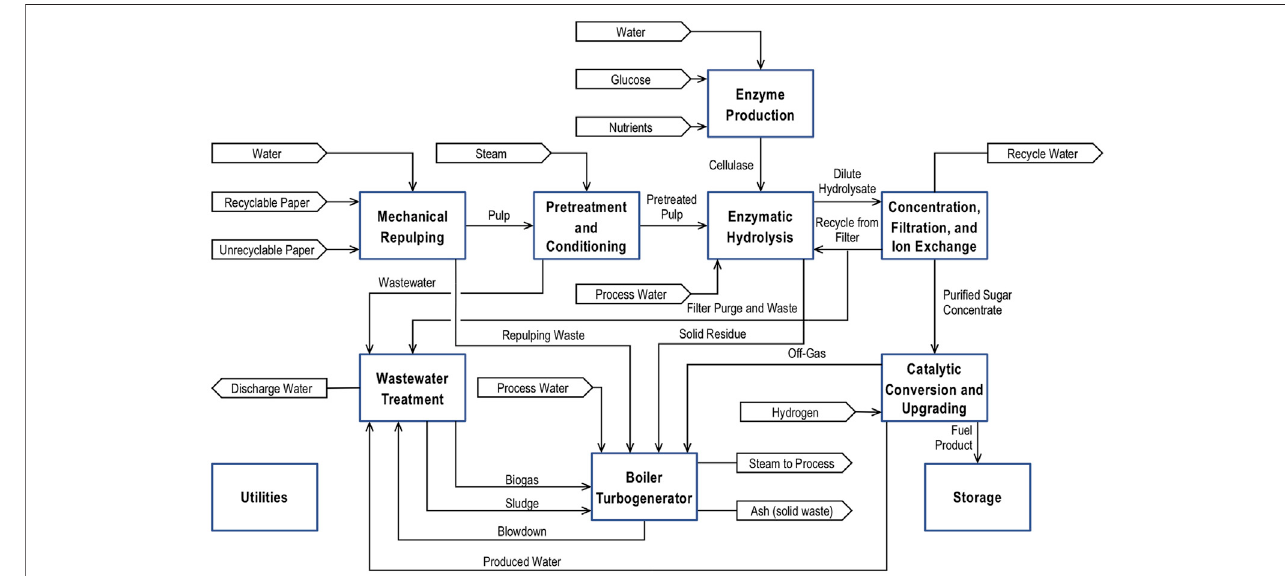
FIGURE 3 | A block diagram of a process for converting recycle paper into jet fuel with enzymatic hydrolysis.